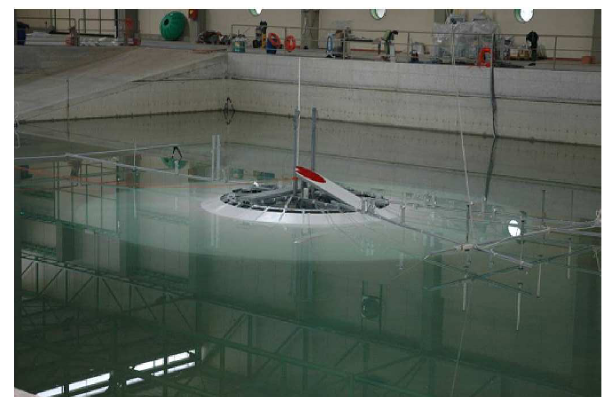
Fig. 1. Sketch of the plan view layout of the laboratory experiments (measures in m). Fig. 2. Picture of the landslide and island